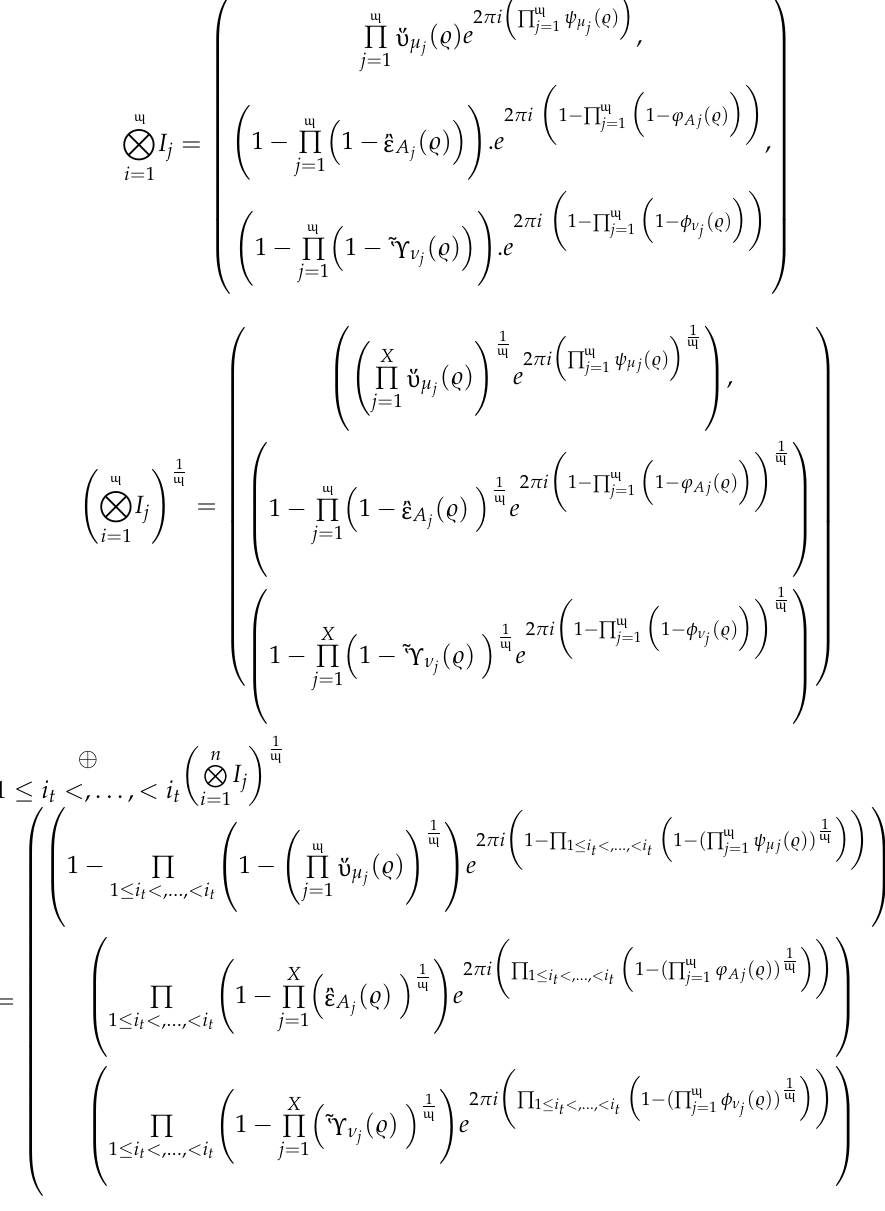
Table 1. Symbols and their meanings.